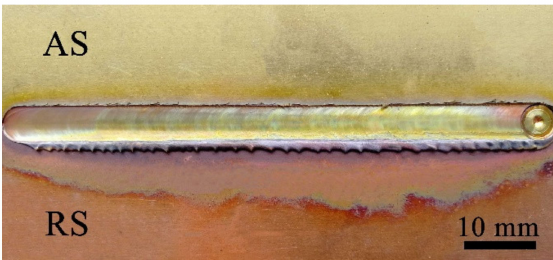
Figure 3. The surface appearance of H62 / T2